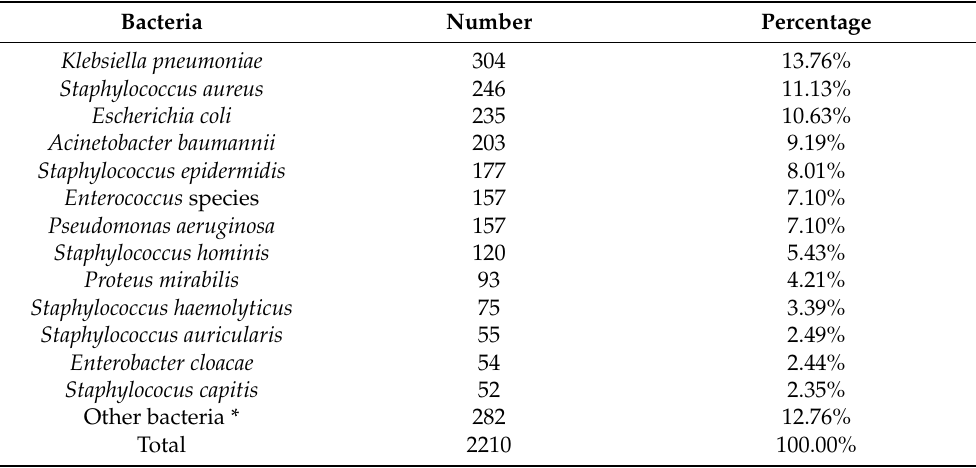
Table 3. The most prevalent bacteria in patients aged more than 63 years.